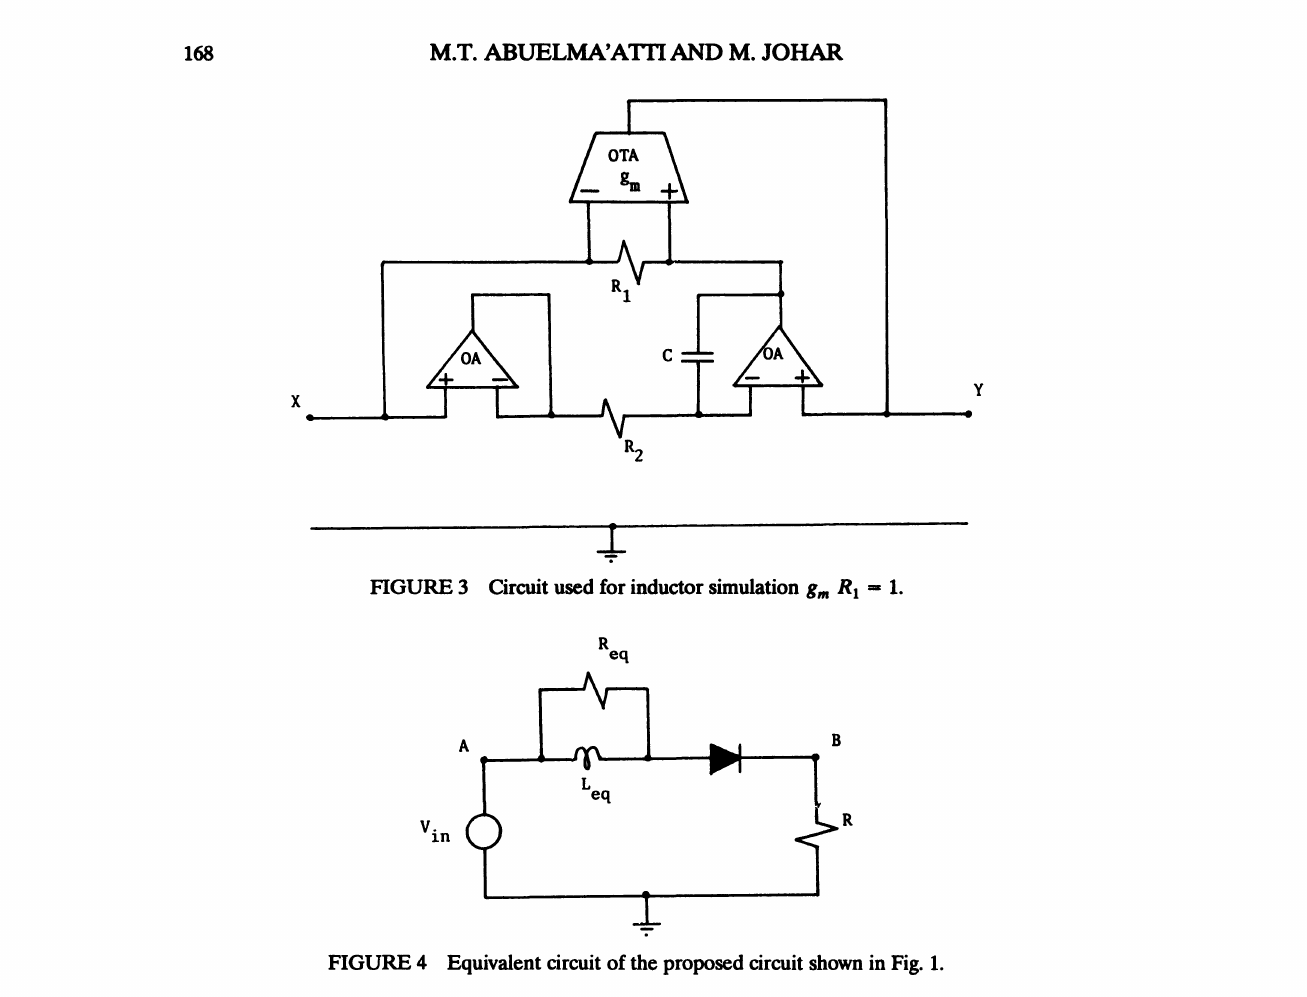
FIGURE 4 Equivalent circuit of the proposed circuit shown in Fig.